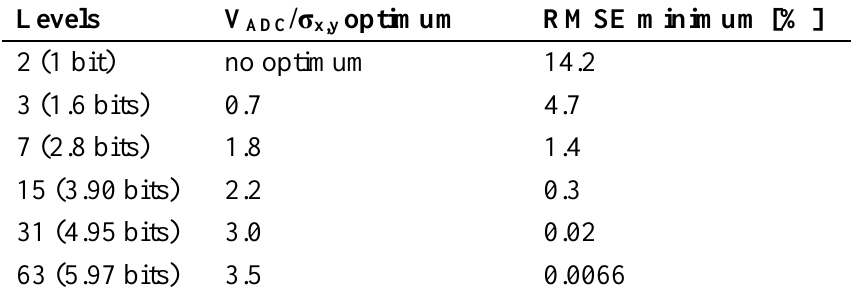
Table 1. Summary of the critical design parameter VADC/σx,y. Relationship between its optimal configuration and the minimum root mean square error obtained for some quantization schemes.